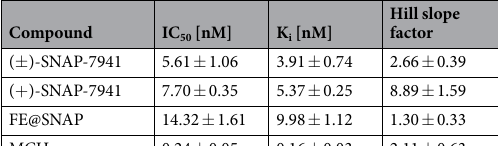
Hill slope factor